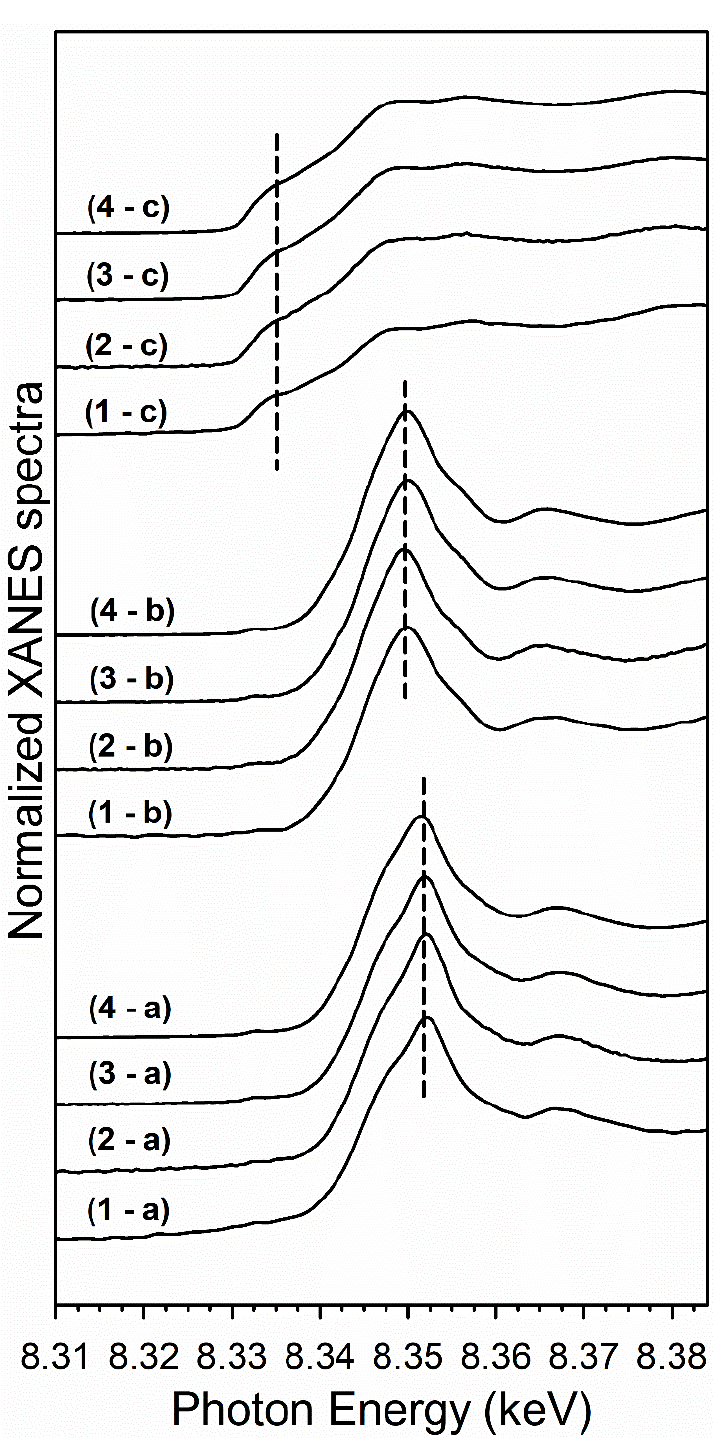
Figure 13. Ni K-edge XANES spectra of ( a ) the initial point consisting of primarily NiO associated with Co 3 O 4 , ( b ) the point consisting of primarily NiO associated with CoO, and ( c ) the final spectrum consisting of primarily Ni 0 for ( 2 ) 25%M (M = 5%Ni-95%Co) / Al 2 O 3 , ( 3 ) 25%M (M = 10%Ni-90%Co) / Al 2 O 3 , ( 4 ) 25%M (M = 25%Ni-75%Co) / Al 2 O 3 .